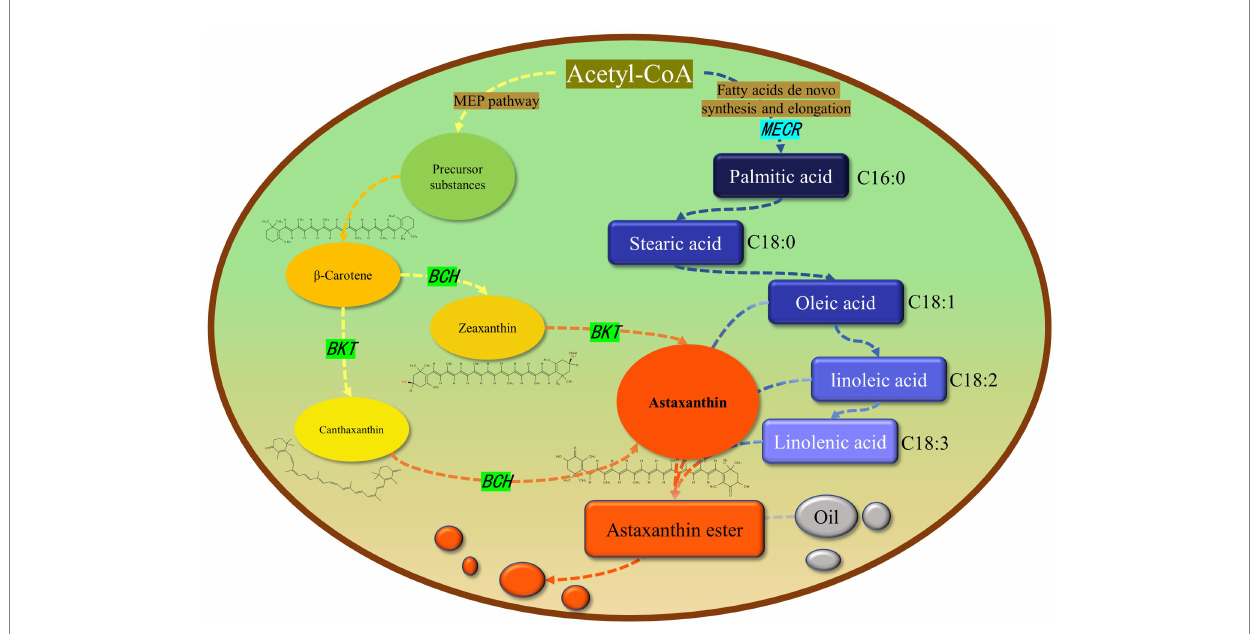
FIGURE 11 Relationship between astaxanthin and lipid metabolism in Haematococcus pluvialis. Most astaxanthin is esterified with fatty acids to form astaxanthin ester, which is then dissolved in oil droplets in cells and diffused in cells. Green and light blue indicate the genes we operate on and their location in the metabolic pathway. The arrow represents a logical relationship. We only show the content related to our